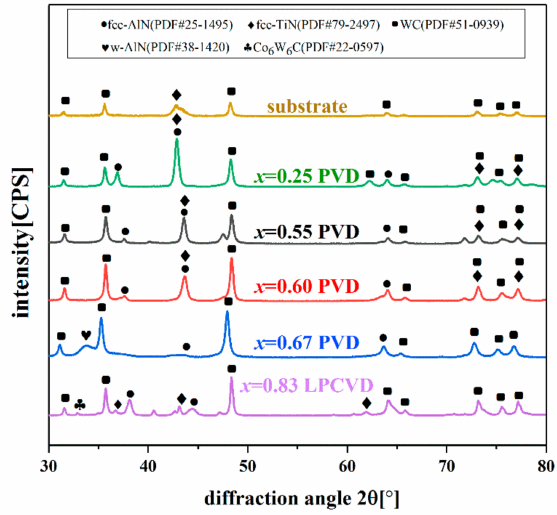
Figure 1. X-ray diffractograms of the substrate and Ti 1 − x Al x N